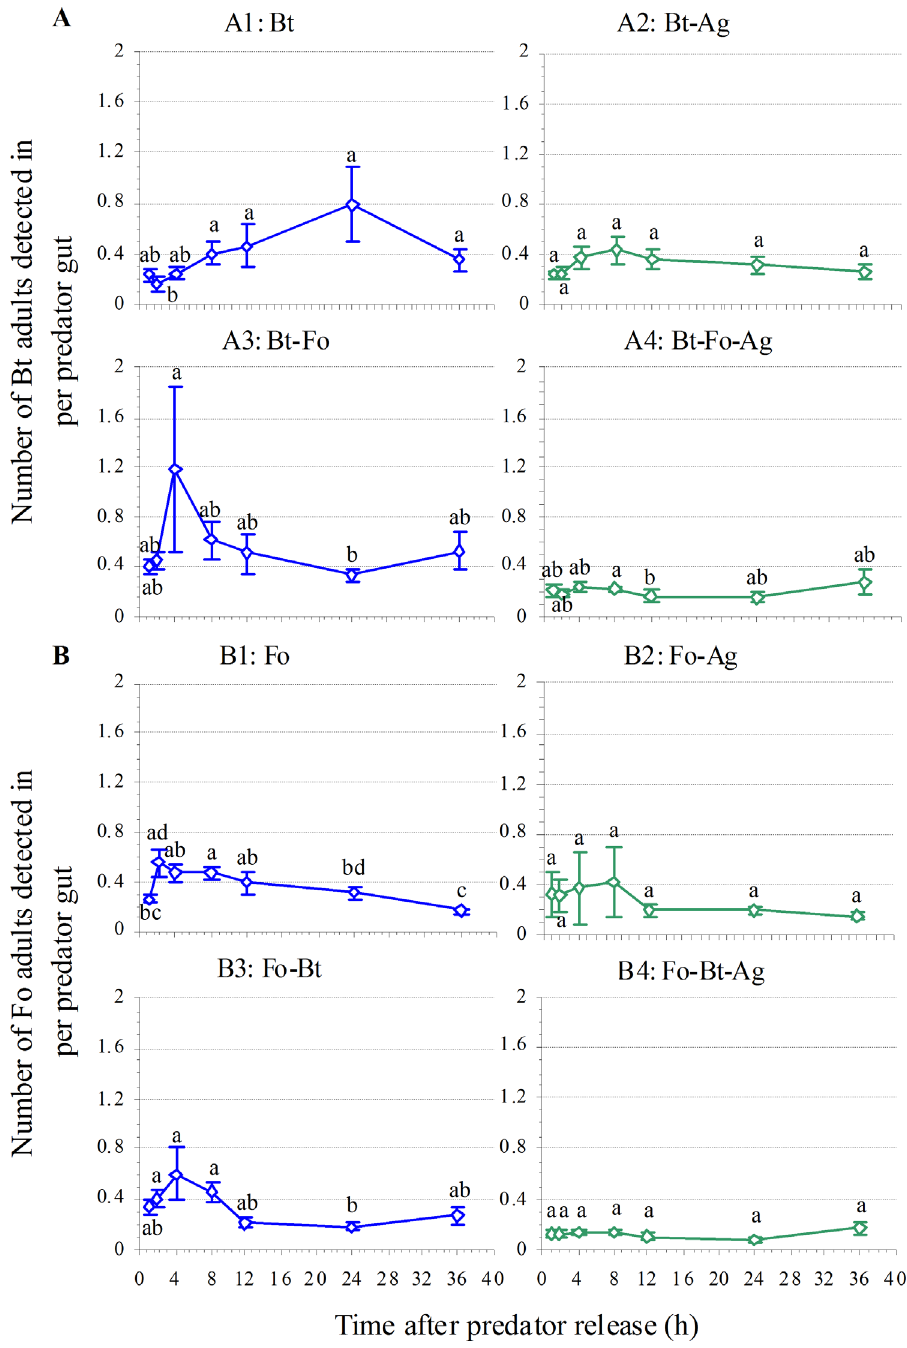
Fig 2. Mean number of (A) Bemisia tabaci MEAM1 (Bt) or (B) Frankliniella occidentalis (Fo) adults detected in Harmonia axyridis gut (n = 15 ladybird beetles; ± 1 SE) in various prey species combinations . Means within a treatment followed by different lower case letters differ at P < 0.05 (one-way ANOVA, LSD test). Abbreviation: Ag — A . gossypii .